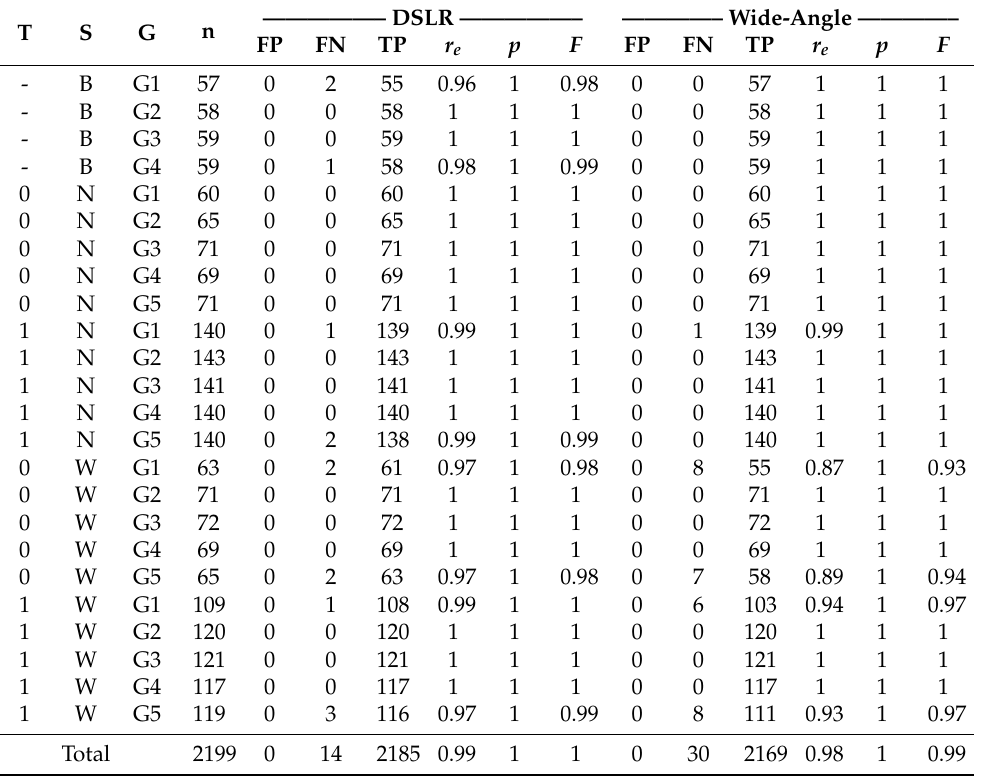
Table 2. Accuracy assessment results of DSLR- and wide-angle-derived manual individual tree detection based on false positive (FP), false negative (FN), true positive (TP), recall ( r e ),